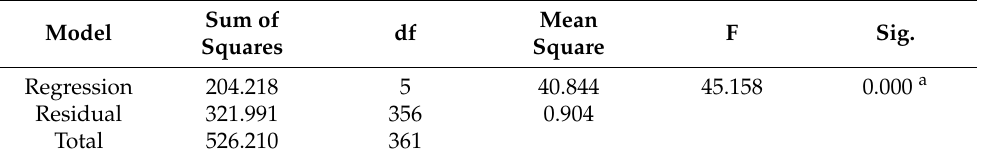
Table 11. Regression 3: ANOVA b